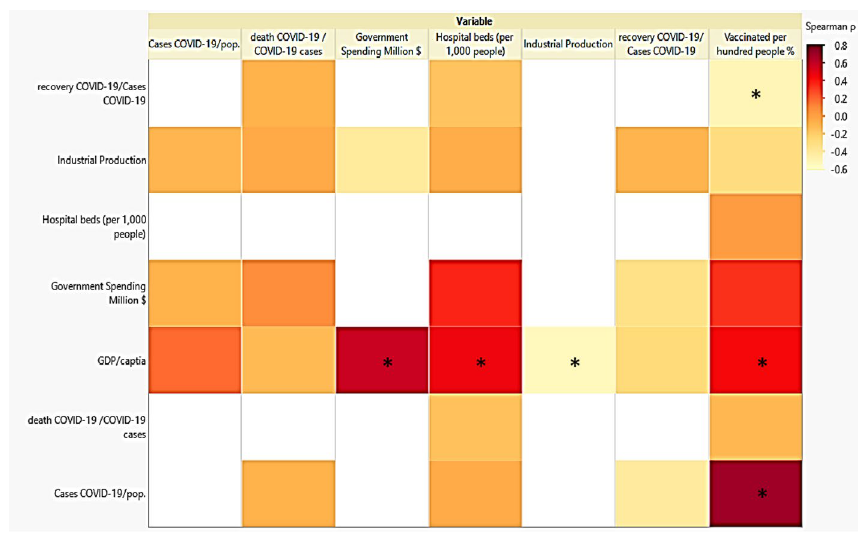
Fig. 2 Correlation heatmap of all studied variables (*denotes sig.